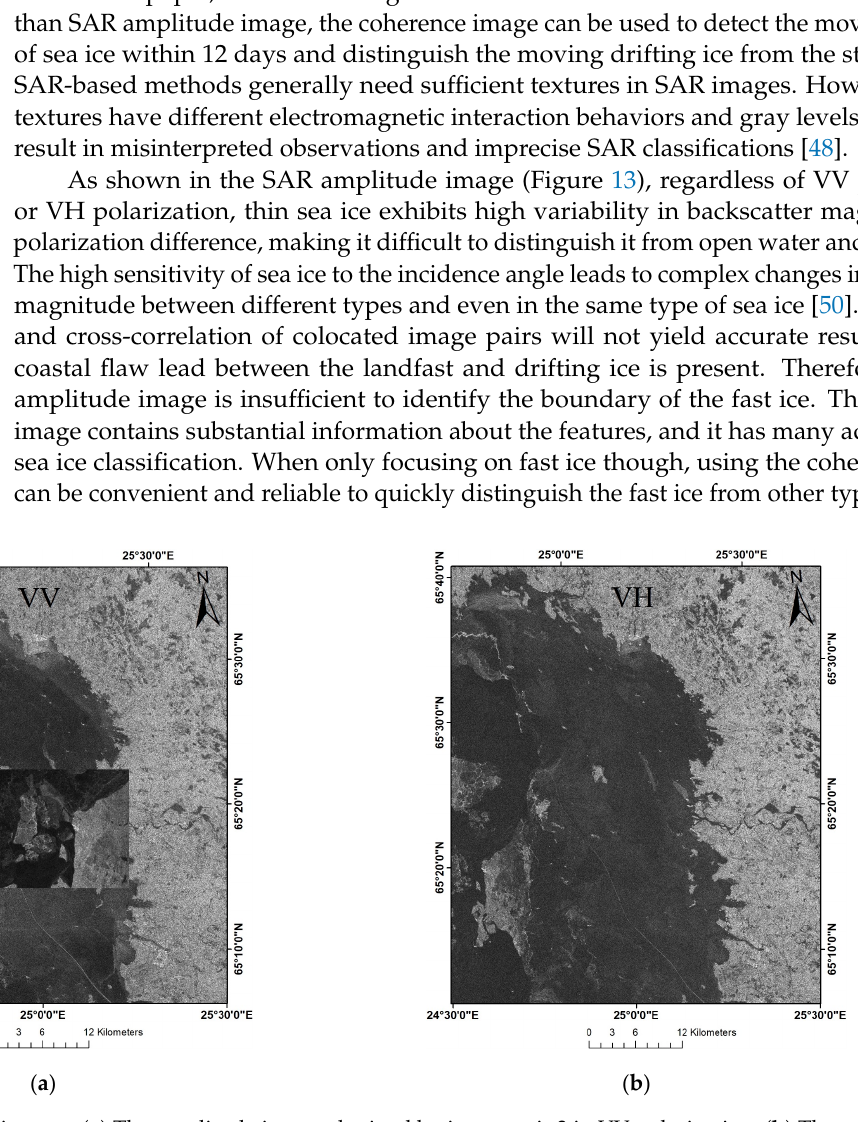
Figure 12. Cumulative frequency histogram of distance from sampling points of the land–water boundary to the NOAA global coastline. Blue bars represent the number of point, and the line represents the cumulative frequency.